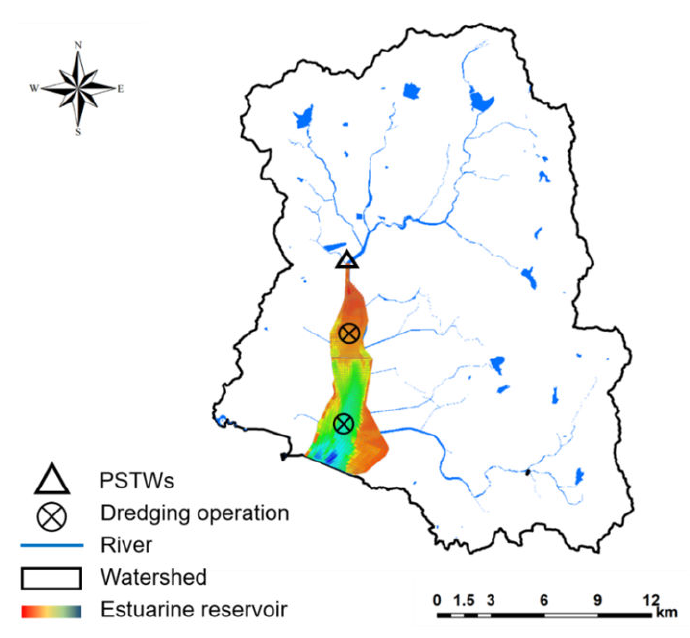
Figure 4. Locations of the dredging operation and PSTWs.